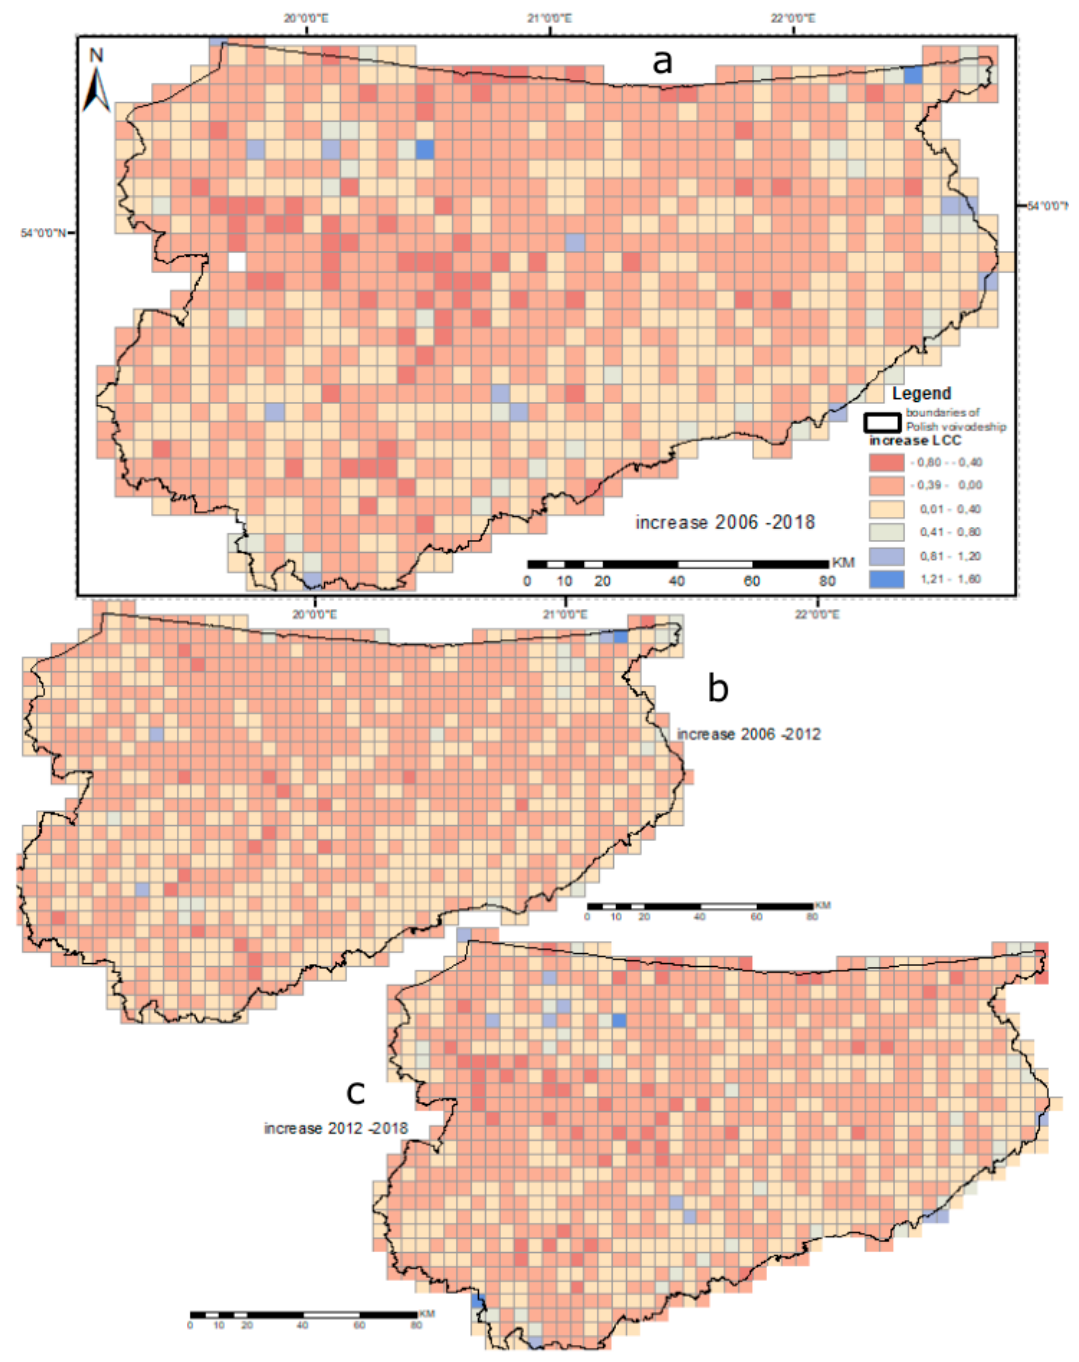
Figure 5. Classification of the increase in the values of the LCC indicator based on data for 2006–2018 ( a ), 2006–2012 ( b ), and 2018 ( c ).